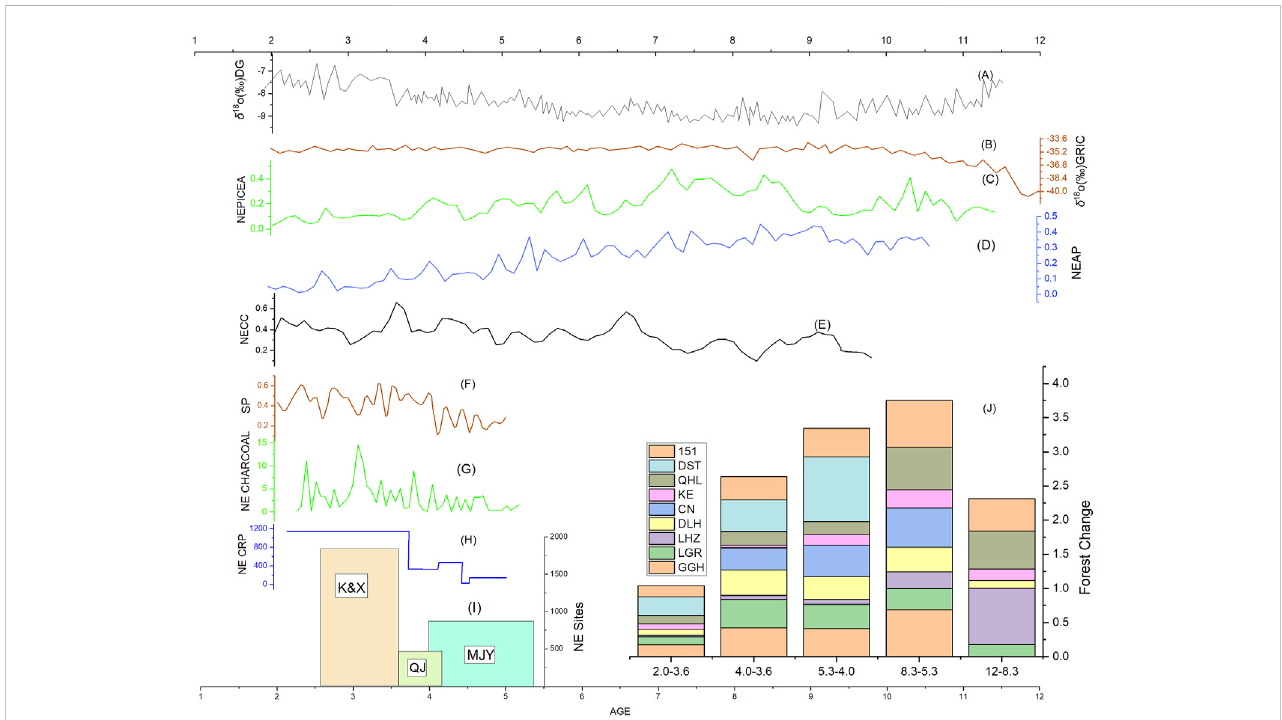
Relationships between climate change, forest dynamics, and human activities. (A) Greenland ice core oxygen isotope records representing global temperaturechanges(Anklinetal.,1993); (B) OxygenisotoperecordsofstalagmitesinDonggeCaveindicatingtheintensityofIndianmonsoon(Dykoskietal., 2005); (C) NormalizedPollenrecordofPiceafromtheNortheastTibetanPlateau; (D) NormalizedPollenrecordofarborealpollenfromtheNortheastTibetan Plateau; (E) Normalized Carbon concentration record in the Northeast Tibetan Plateau; (F) Record of synanthropic plants through integrative pollen analysis in Northeast Tibetan Plateau during 5.5 – 2.0 ka BP (Chen X. L et al., 2020); (G) Charcoal concentration in different archeological sites in Northeast Tibetan Plateau during Mid-late Holocene (Liu et al., 2022); (H) Changes in cropland during the mid to late Holocene in the NETP (Wende et al., 2021); (I) Number of archaeological sites in the Northeast Tibetan Plateau. (J) Dynamic changes in arboreal pollen from different sites in Northeast Tibetan Plateau indicating change in forested